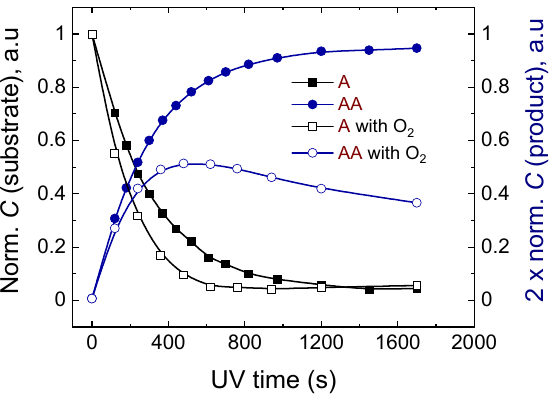
Figure 4. The effect of oxygenation of the sample on the photodimerization curves ( λ = 365 nm) derived from 400 MHz 1 H-NMR spectra of anthracene ( A ).